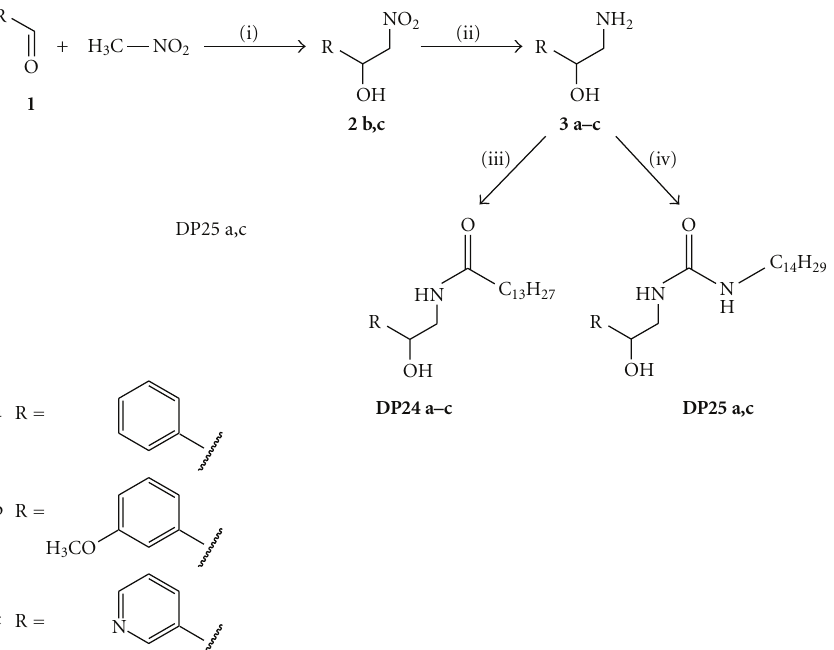
Figure 4: Synthetic route to the aCDase inhibitors DP24 a–c and DP25 a,c . Reagents and conditions: (i) triethylamine, r.t., 2–6 hrs; (ii) H 2 , Pd/C, methanol, r.t., 16hrs; (iii) myristoyl chloride, pyridine, 4hrs; (iv) tetradecyl isocyanate, acetonitrile/chloroform, r.t. 6hrs.